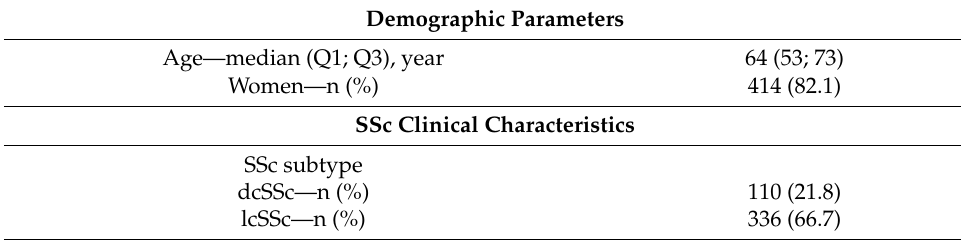
Figure 1. Participant flow chart. EFS: Etablissement français du sang. Table 2. Patients’